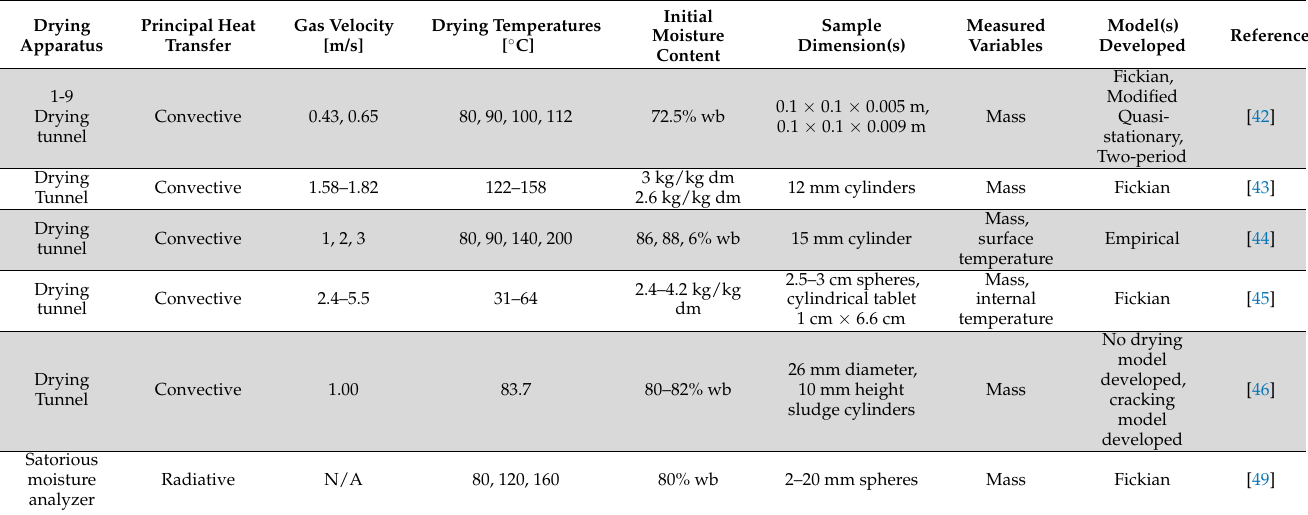
Table 2. Summary of drying conditions and models